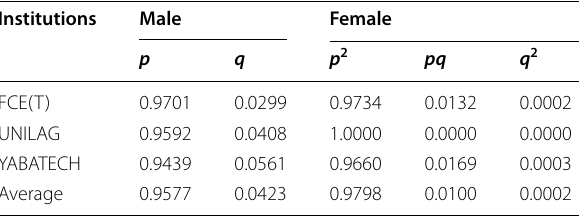
Table 6 Genotypic frequencies of colour vision deficient